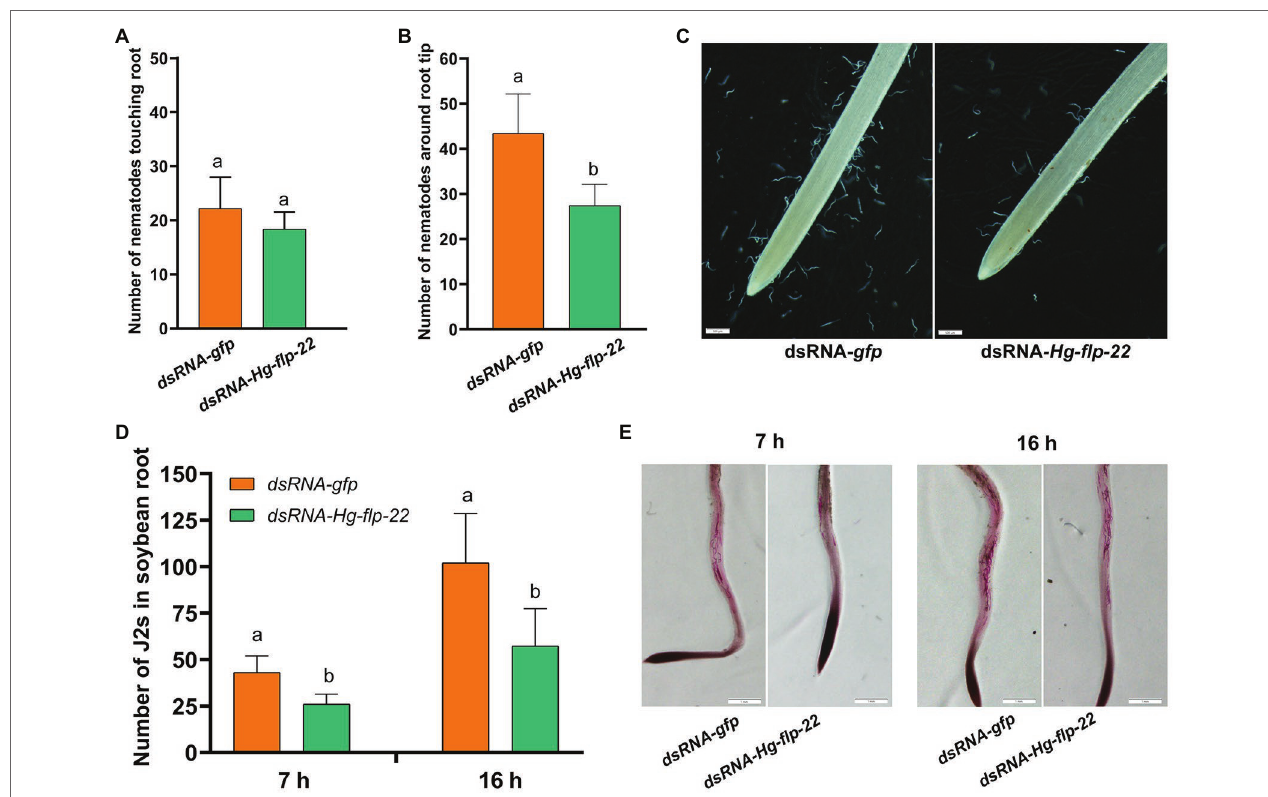
FIGURE 4 | Effect of in vitro RNAi of Hg-flp-22 on H. glycines attraction and penetration in PF-127 medium. (A) The number of nematodes touching or within 5 mm of the root was counted at 4 h after starting the assay. Data are the means ± SD ( n = 10) and are representative of three independent experiments. Statistical analysis was performed using Tukey’s HSD test. The same letters indicate no significant differences between treatments ( p > 0.05). (B) The number of nematodes around the root within the terminal 5 mm was counted at 4 h after starting the assay. Data are the means ± SD ( n = 10), and bars with the same letter indicate no significant difference at p > 0.05 (Tukey’s HSD test). J2s soaked with gfp dsRNA were used as the control. (C) Representative images showing the attraction of Hg-flp-22 dsRNA-treated J2s toward soybean root tips in PF-127 medium at 4 h after starting the assay. Scale bar = 500 μ m. (D) The number of stained J2s inside the root was counted at 7 and 16 h after starting the assay. Values are the mean ± SD from one representative experiment ( n = 10). The same letter indicates no significant differences at p > 0.05 (Tukey’s HSD test). J2s treated with gfp dsRNA were used as the control. (E) Stained J2s in soybean roots. Scale bar = 1